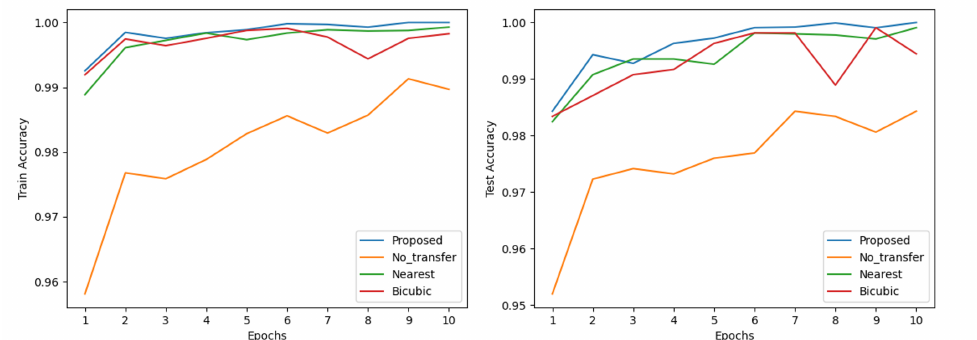
Figure 6. The changing trend of accuracy with training epochs.